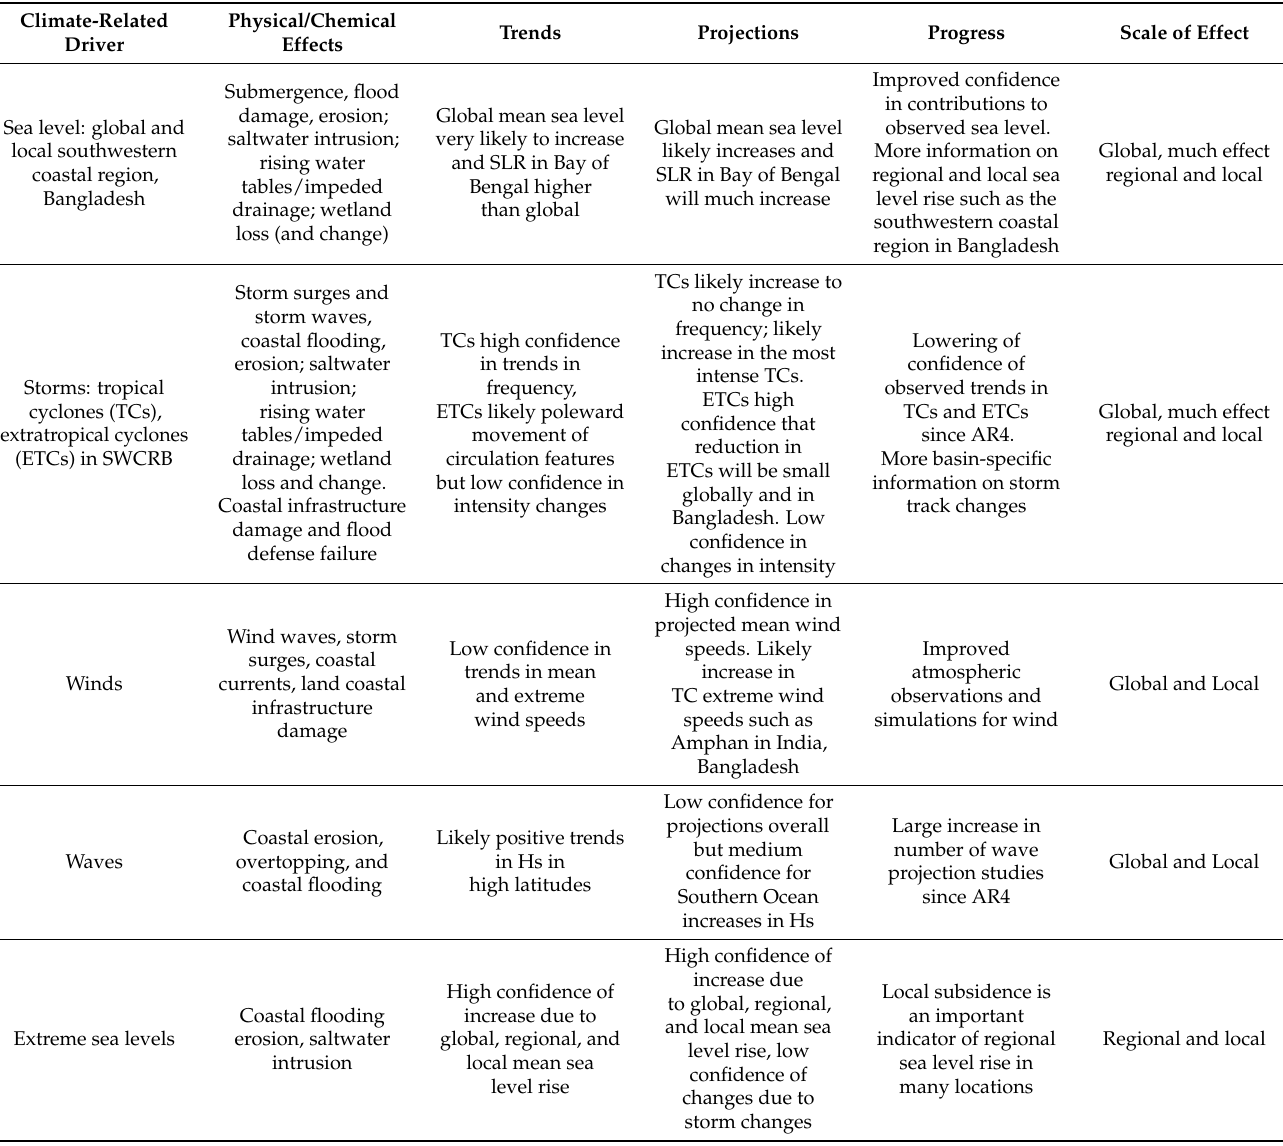
Table 8. Summary of different effects, projections, etc., for local, regional, and global sea level changes. (Adopted by IPCC, 2014)